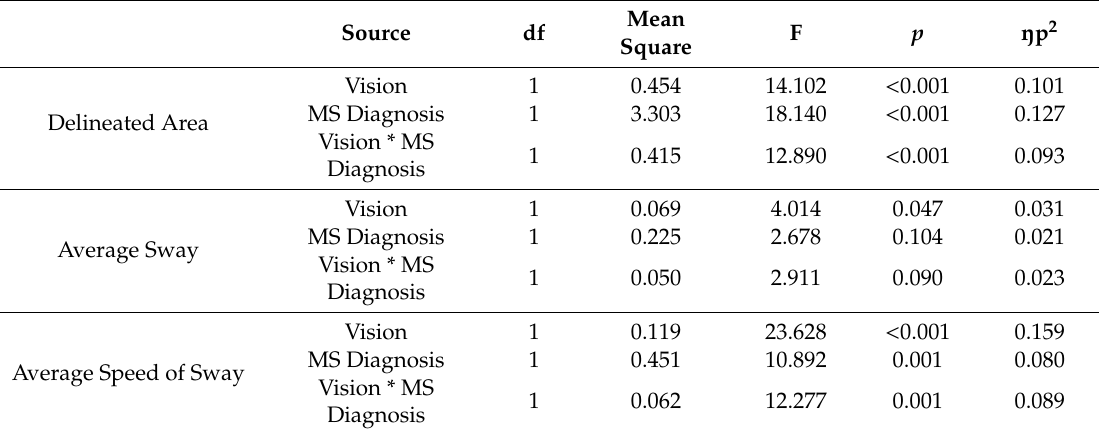
Table 3. Summary of two-way mixed ANCOVA results across static posturography balance parameters.